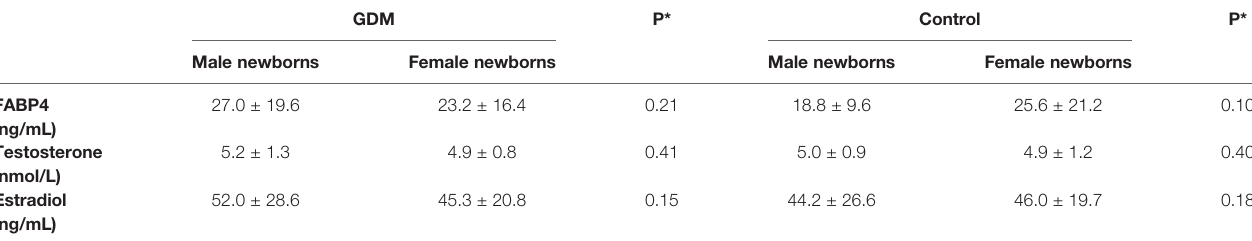
TABLE 3 | Cord plasma FABP4, testosterone and estradiol concentrations comparing male vs . female newborns in GDM and euglycemic (control) pregnancies. GDM P*